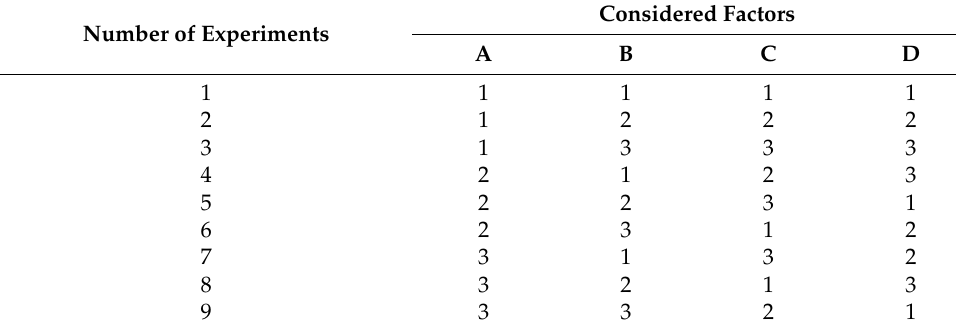
(cid:0) (cid:1) 3 4 .